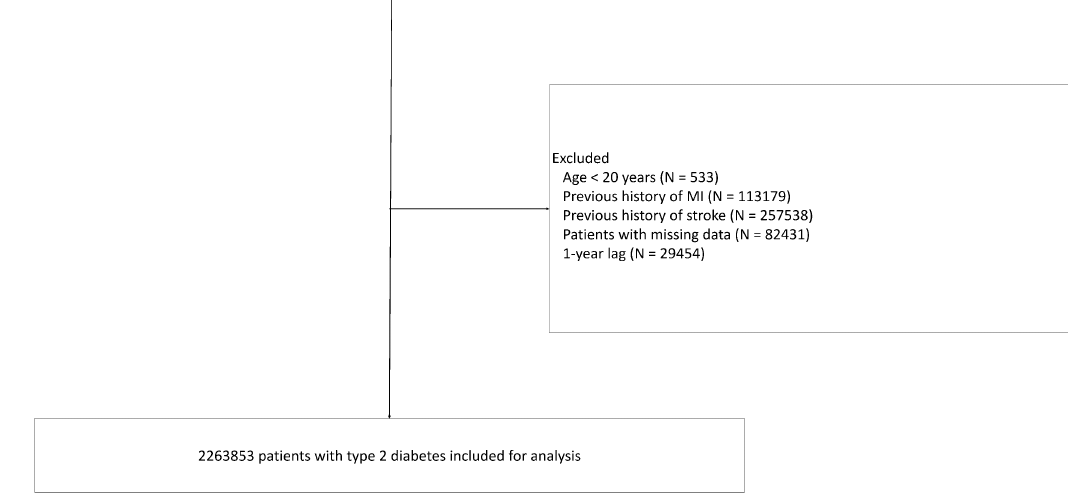
Figure 1. Flowchart depicting inclusion of patients. NHIS, National Health Insurance Service; MI, myocardial